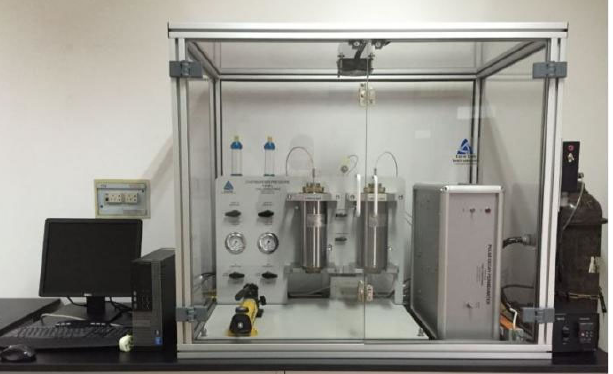
Figure 5. Pulse decay permeameter.